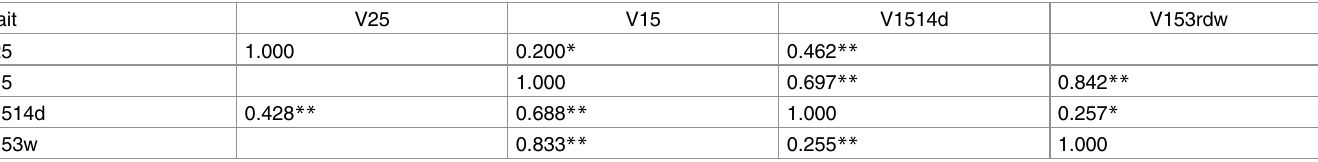
Table 2. Significant correlations (Spearmancoefficients) among four coleoptile growth rates (mm/d) determined at 25 (V25) or 15˚C (V15, V1514d, V153w). Trait